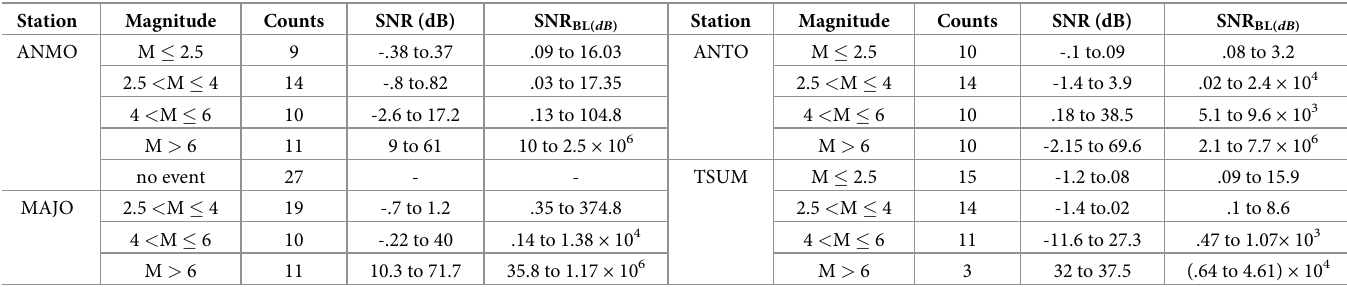
Table 4. Seismic data. Details of different datasets downloaded from